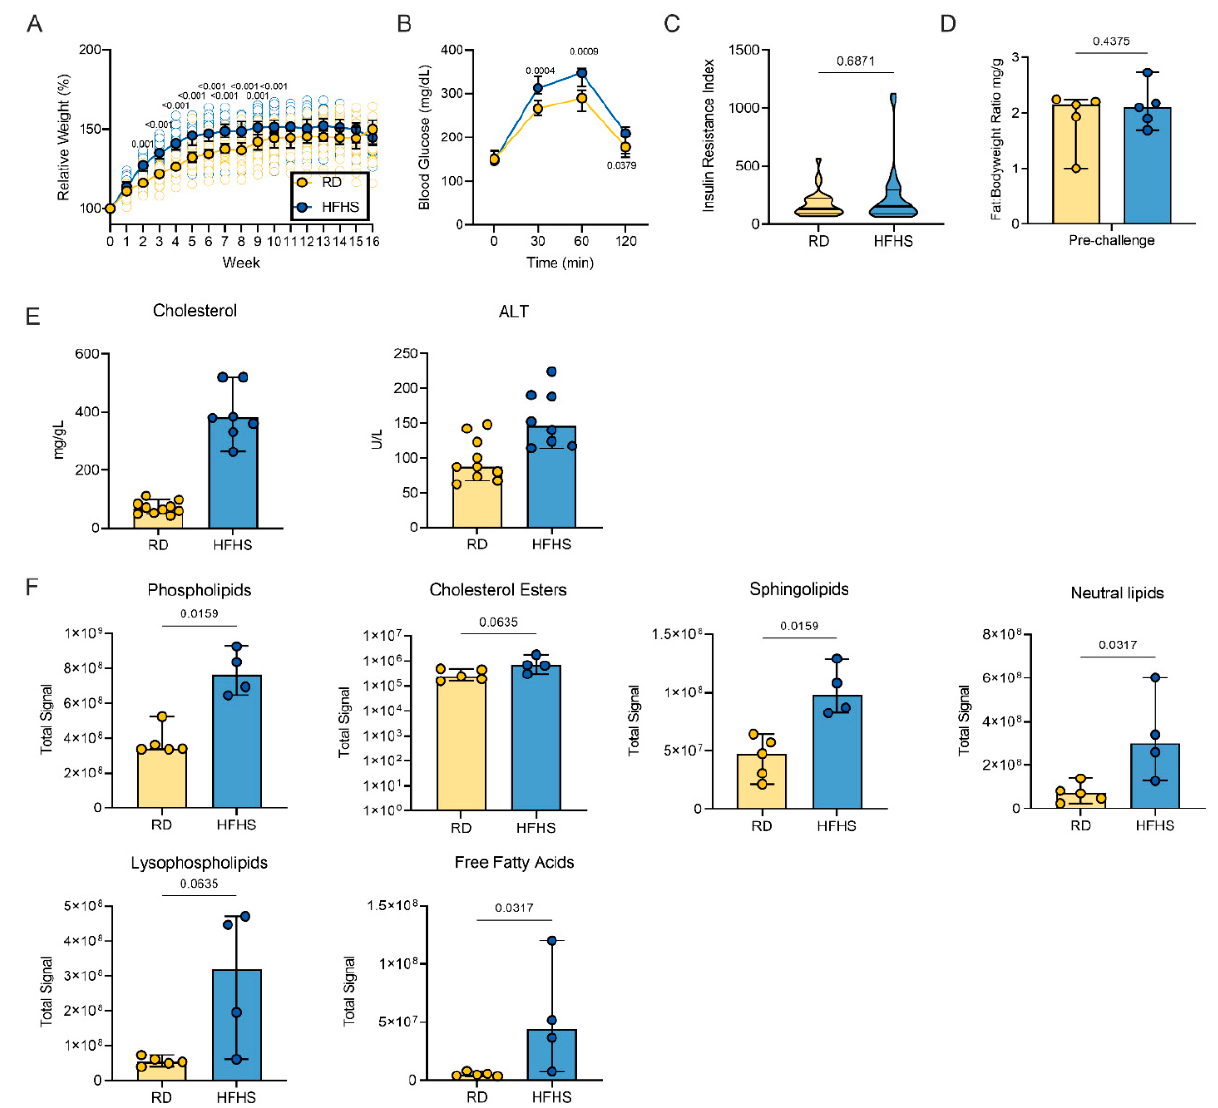
Figure 1. High-fat and high-sugar diet induces metabolic changes characterized by increased juvenile weight gain and glucose tolerance. Male Syrian hamsters were fed either a regular or high-fat high-sugar diet ad libitum for 16 weeks. ( A ) Relative weight gain in hamsters on each diet regimen, measured weekly. Graphs show median ± 95% CI, n = 35, ordinary two-way ANOVA, followed by Sidak’s multiple comparisons test. ( B ) Oral glucose tolerance test performed at 16 weeks. Graphs show median ± 95% CI, n = 30 (RD)/29 (HFHS), ordinary two-way ANOVA, followed by Sidak’s multiple comparisons test. ( C ) Insulin response after application of oral glucose load as shown by insulin resistance index (fasting glucose level (mmol/L) x fasting insulin level (mIU/L)). Truncated violin plots depicting median, quartiles and individuals, n = 30 (RD)/29 (HFHS), Mann–Whitney test. ( D ) Adiposity index as measured by testicular fat pads/total body weight at 16 weeks. Bar chart depicting median, 95% CI and individuals, n = 5, Mann–Whitney test. ( E ) Blood lipid ALT and cholesterol levels measured on a commercially available lipid panel on an automated blood chemistry analyzer n = 10 (RD)/8 (HFHS) (see Table S1). ( F ) Serum aggregate lipids signal analyzed by liquid chromatography tandem mass spectrometry (LC-MS/MS) at 16 weeks of diet regimen. Bar chart depicting median, 95% CI and individuals, n = 5 (RD)/4 (HFHS), Mann–Whitney test. Abbreviations: RD = regular diet; HFHS = high-fat high-sugar; ALT = alanine aminotransaminase. p -values are indicated were appropriate.